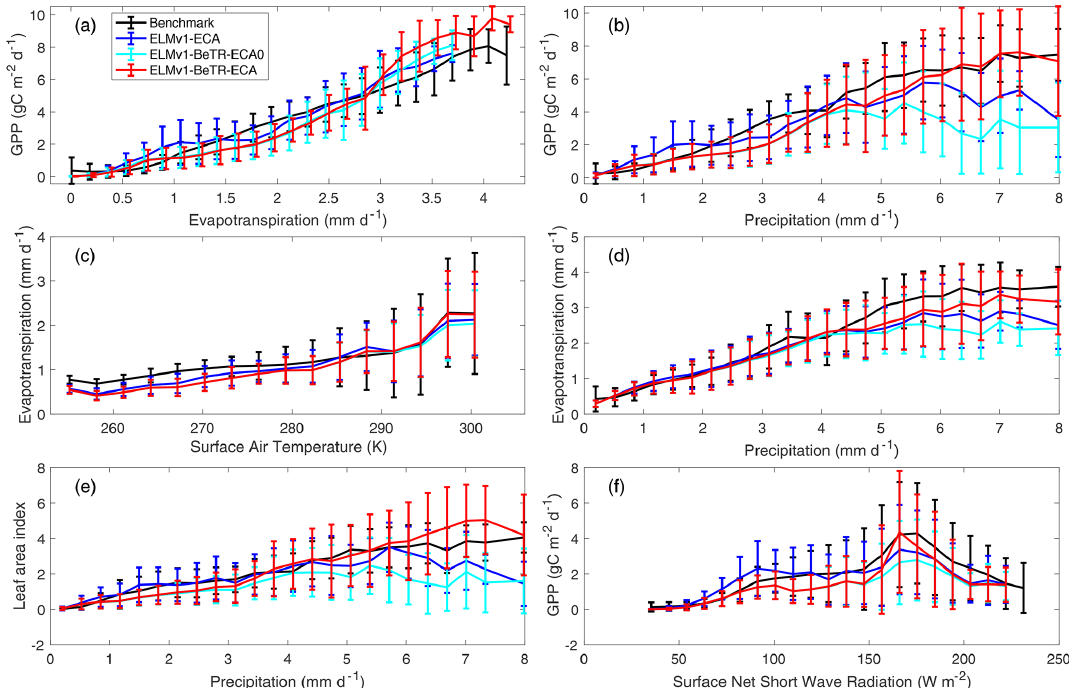
Figure 5. Benchmark of simulated vs. empirical data-derived variable relationships. The empirical benchmarks are derived from FluxCom output for the period from January 1980 through December 2013 (Jung et al., 2017; Tramontana et al., 2016) and used in ILAMB.